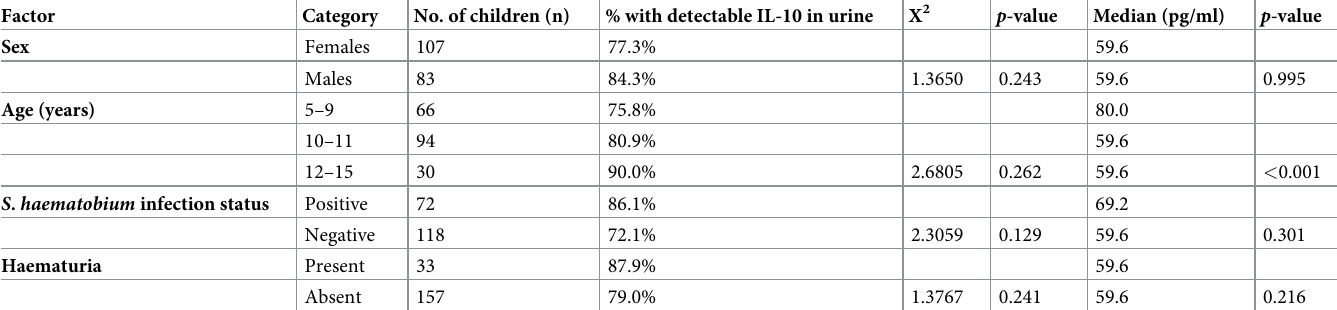
Table 4. Association between the prevalence of IL-10 and gender, age, S . haematobium infection status, and haematuria. Factor